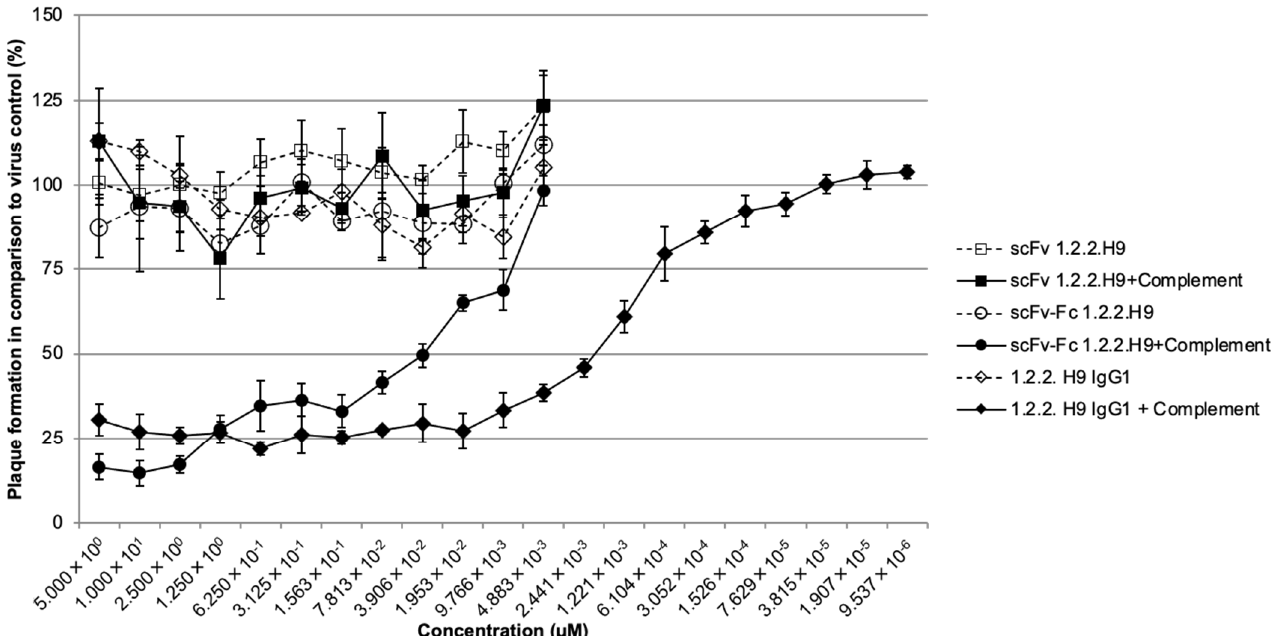
Figure 8. The PRNT was performed in triplicates with a starting concentration of 10 µM of the respective 1.2.2.H9 molecule. The scFv-1.2.2.H9 with (filled square) and without (unfilled square) complement, as well as the scFv-Fc-1.2.2.H9 and IgG1-1.2.2.H9 without (unfilled circle and diamond) human complement, showed no neutralization. Neutralization was observed after the addition of 1% human complement for both molecules with an Fc part (filled circle and diamond).